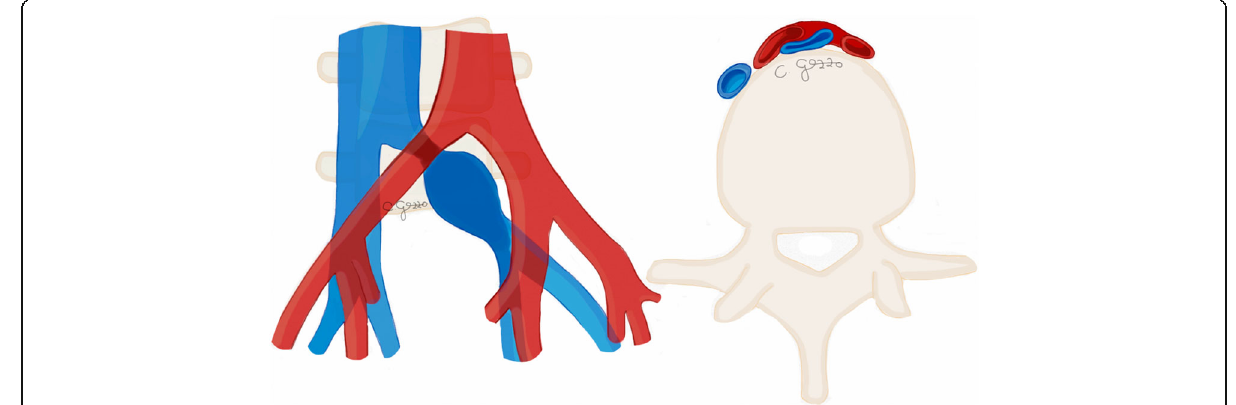
Fig. 8 Drawing illustrating the coronal and axial views of May-Thurner syndrome